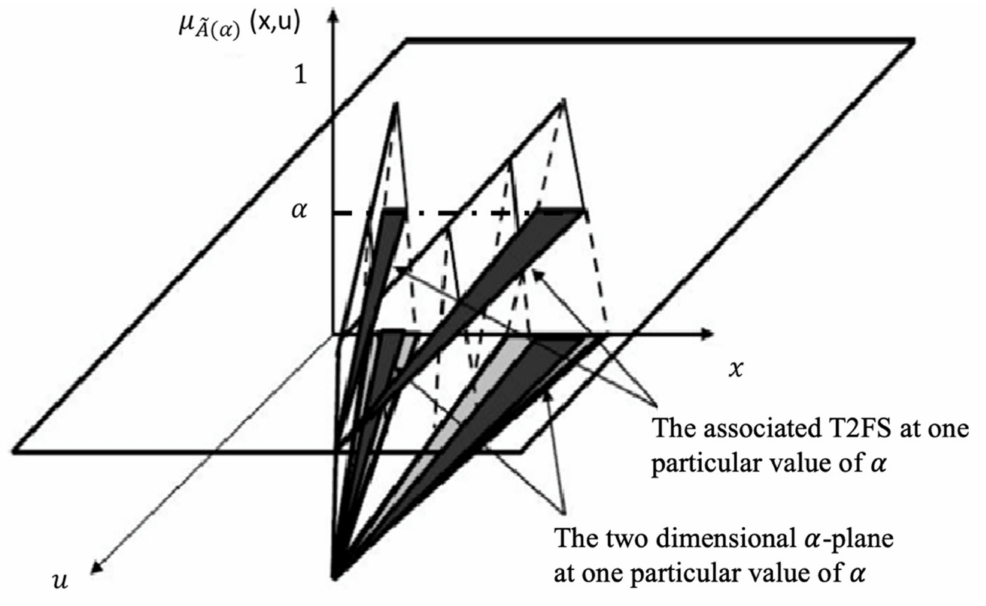
Figure 4. A representation of the associated T2 FS for the α